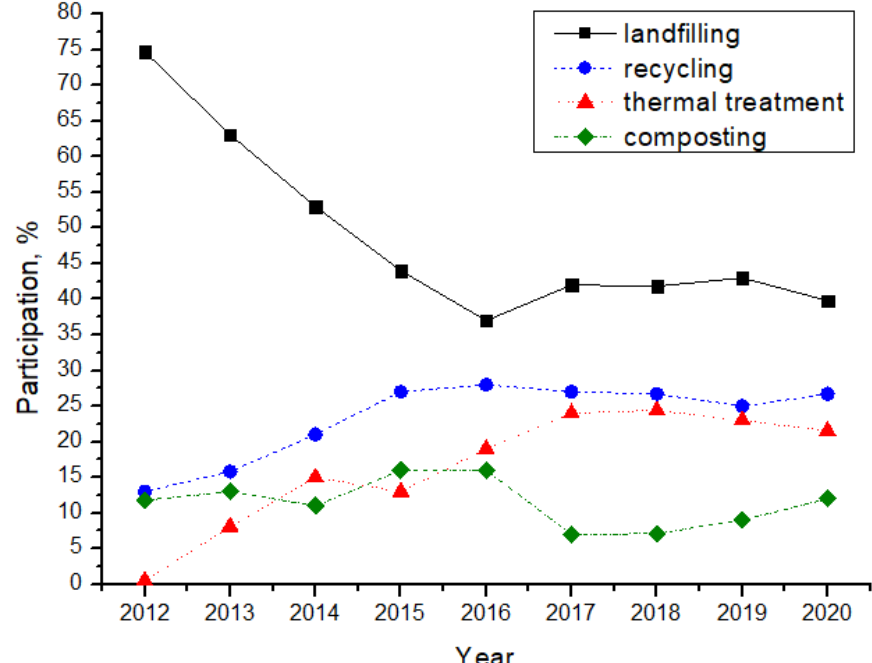
Figure 1. Share of forms of municipal waste management 2012–2020 [3].